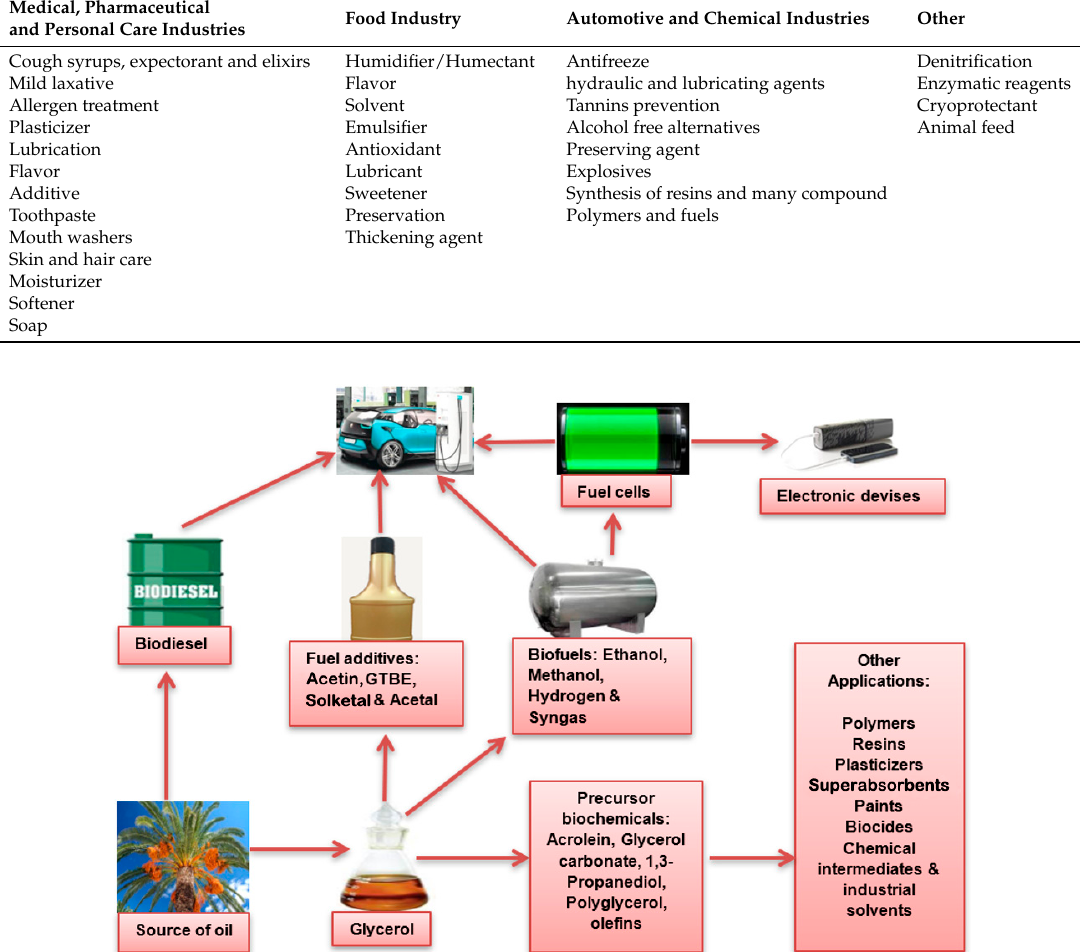
Figure 4. Applications of some glycerol derivatives.